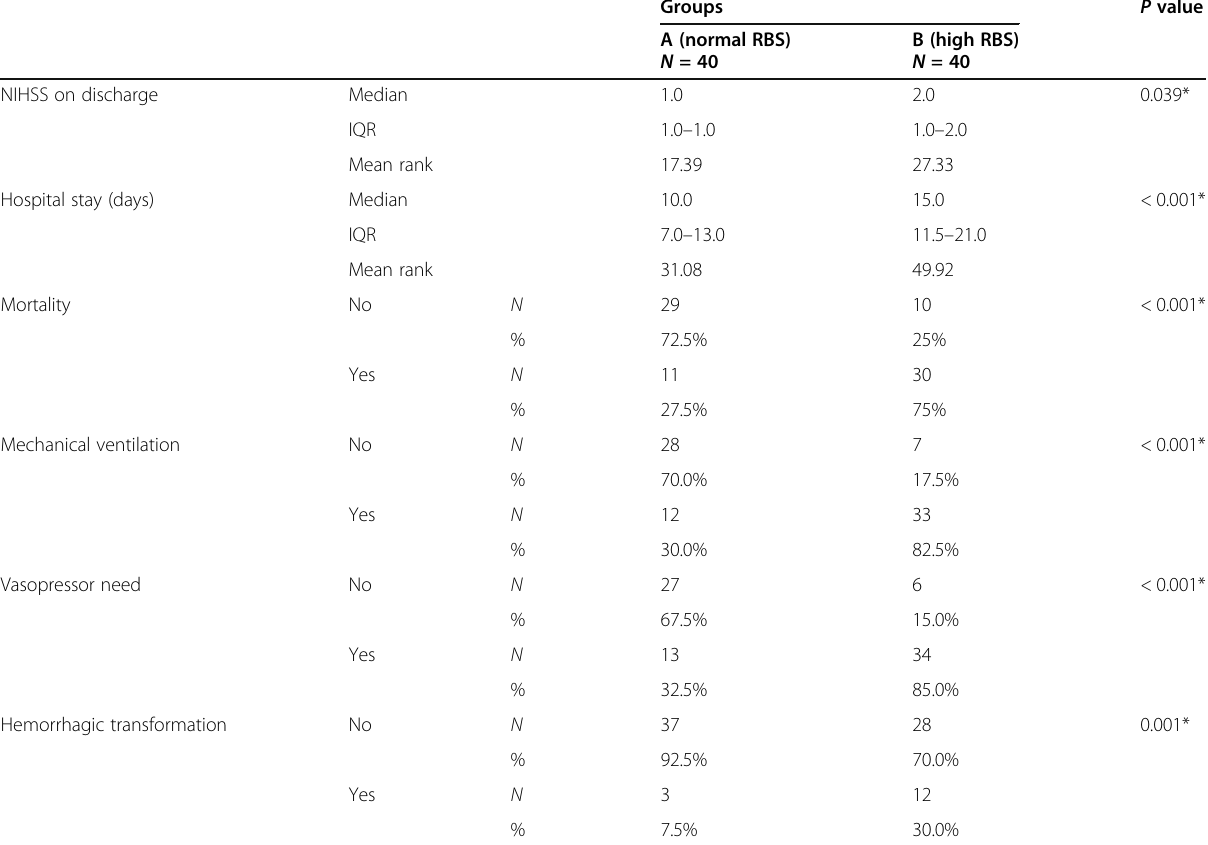
Table 3 Comparison of the studied groups as regards primary and secondary outcomes